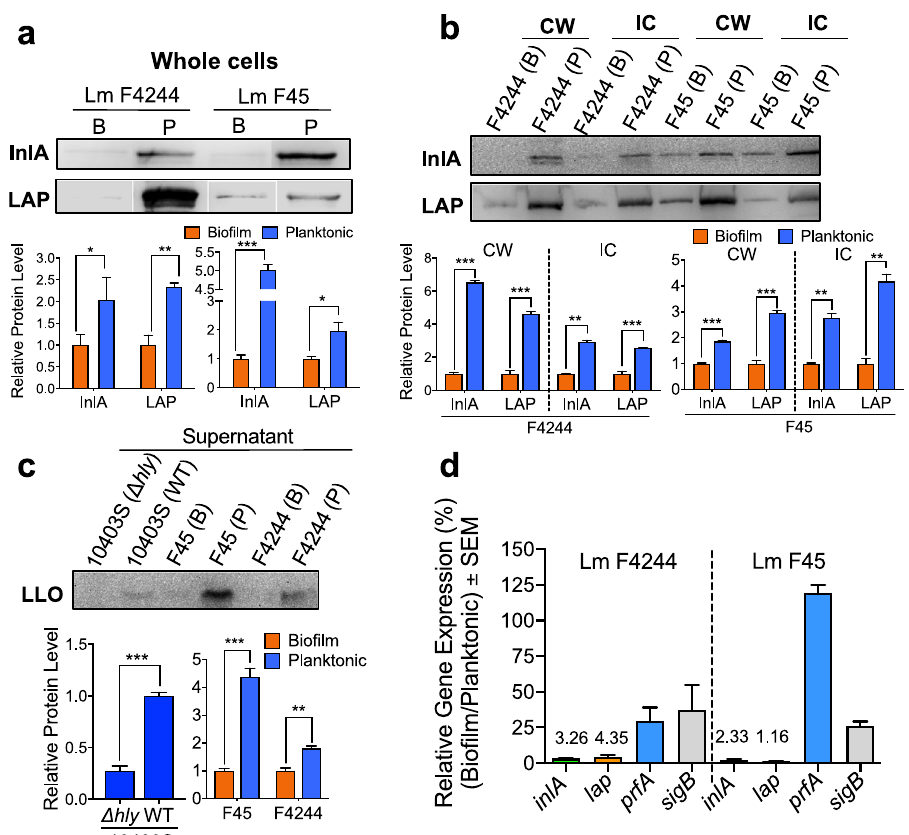
Fig. 4 Comparison of virulence protein expression in bio fi lm-isolated (B) and planktonic (P) L. monocytogenes cells. a , b Immunoblot (top panel) and densitometry (bottom panels) of InlA, and LAP, in the whole cell ( a ), cell wall, and intracellular fractions ( b ) of bio fi lm-isolated and planktonic cultures of Lm F4244 and F45. Immunoblots are representative of three independent experiments. c Immunoblot of LLO in the secreted protein fraction of bio fi lm-isolated and planktonic Lm F4244 and F45. Immunoblots are representative of three independent